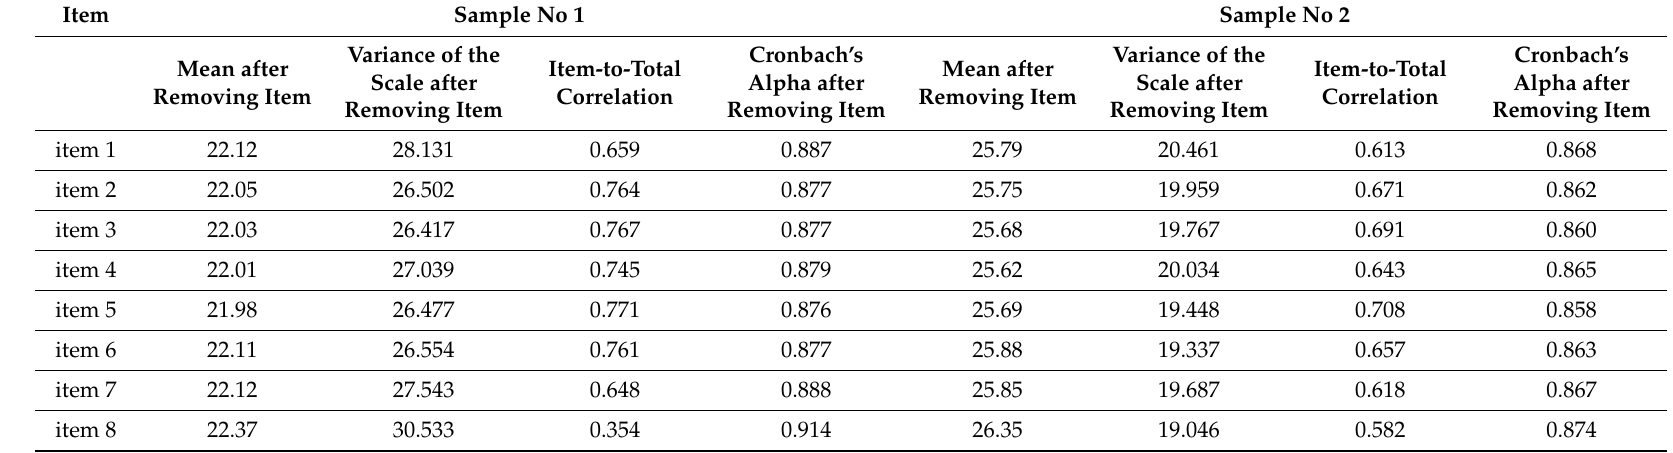
Table 1. Means, item-to-total correlations, and Cronbach’s alphas after removing specific items of the Polish version of the ehealth literacy scale (Pl-eHEALS) for both